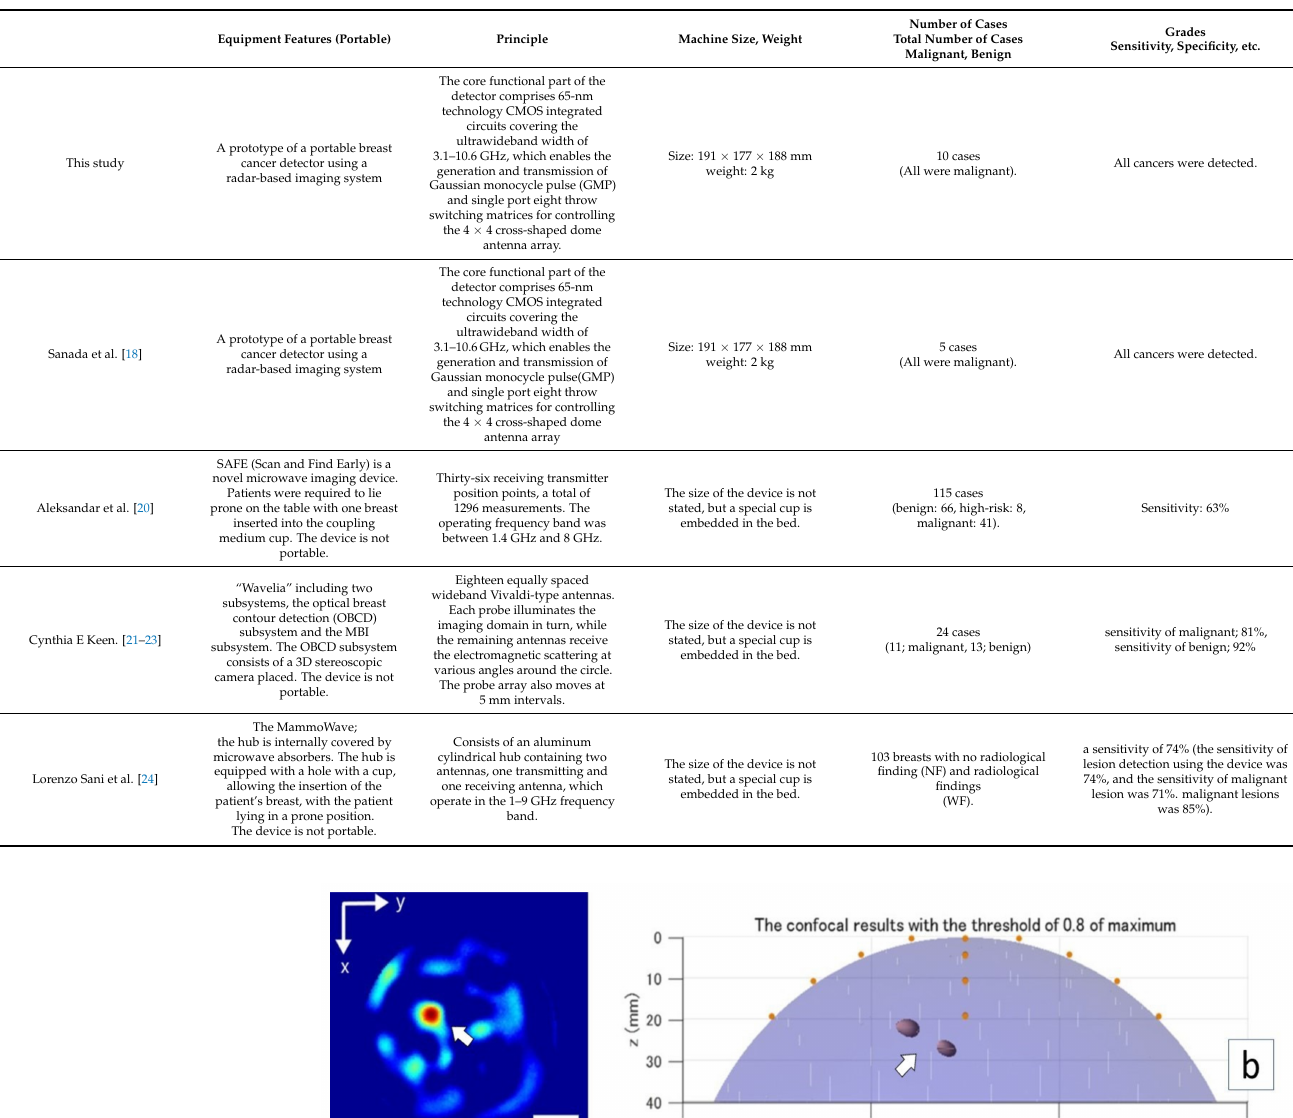
Table 4. Comparison with previous experiments.